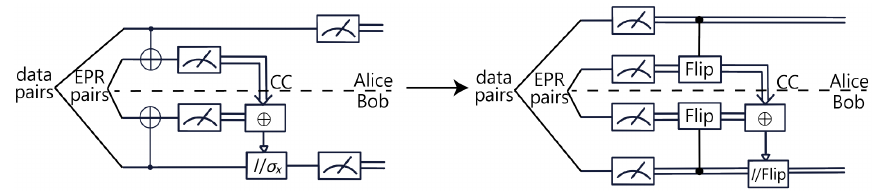
FIG. 7. The transformation from quantum bit-error correction to information reconciliation. The left-hand circuit is the quantum bit-error-correction part in Fig. 1. The “Flip” gate means that Alice and Bob flip the corresponding classical bits. Bob calculates the error syndrome using his parity information and that sent by Alice and then flips his erroneous bits to reconcile the key.